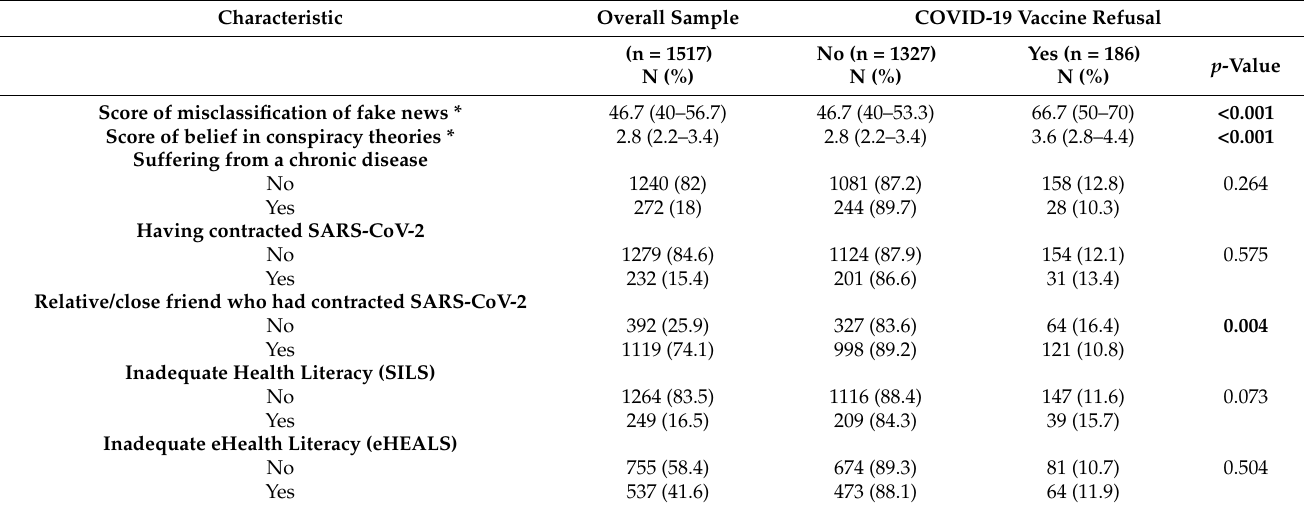
Table 2. Descriptive analyses of secondary outcomes, variables related to health and COVID-19, and relationship with vaccine